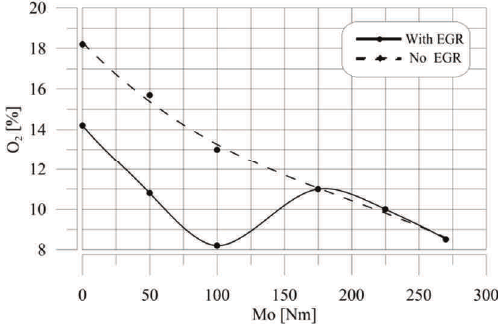
Fig. 20. Influence of the engine load on the O 2 concentration in exhaust gases for engine operating with/without EGR